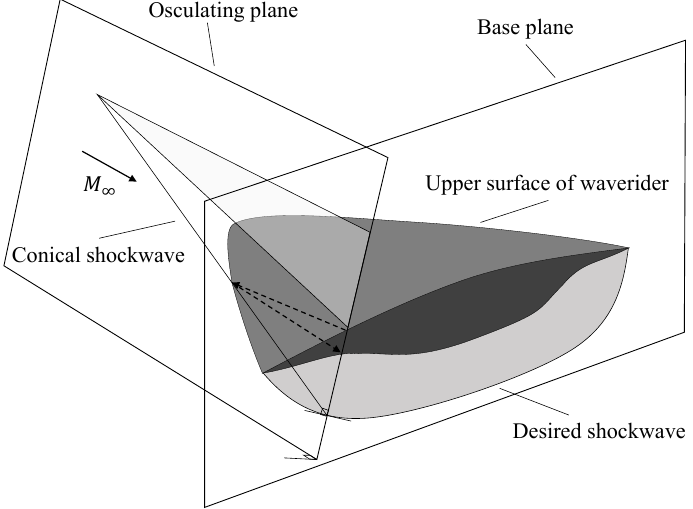
Figure A1. Osculating cone theory based waverider. Subsequently, the process of waverider shape derivation is performed on each osculating plane. Herein, the upper surface on the base plane is defined to derive the waverider shape. After identifying the intersection point with the upper surface in each osculating plane, the point in the upstream direction of free flow is moved, and the intersection point with the shockwave generated by the cone can be determined. This intersection is considered the leading edge of the waverider shape, and the path created by the movement of the point serves as the upper surface of the waverider. This is followed by tracing the streamline of the osculating plane flow at each leading edge, and the generated streamline is used as the bottom surface of the waverider. As the streamline and the wall surface must be parallel according to the boundary conditions of the flow after the shockwave, the wall surface generated by this streamline and the cone of the osculating plane must produce identical shockwaves. Accordingly, when the upper and bottom lines of all osculating planes are combined, a shockwave is attached along the leading edge of the vehicle. In this process of deriving the waverider shape, the flow analysis is performed only for the conical flow of a single shockwave angle, which considerably reduces the time required for the design in comparison with other methods. However, the osculating cone theory can be effectively applied to the design because it can generate sufficiently diverse basic flow field shapes. References 1.